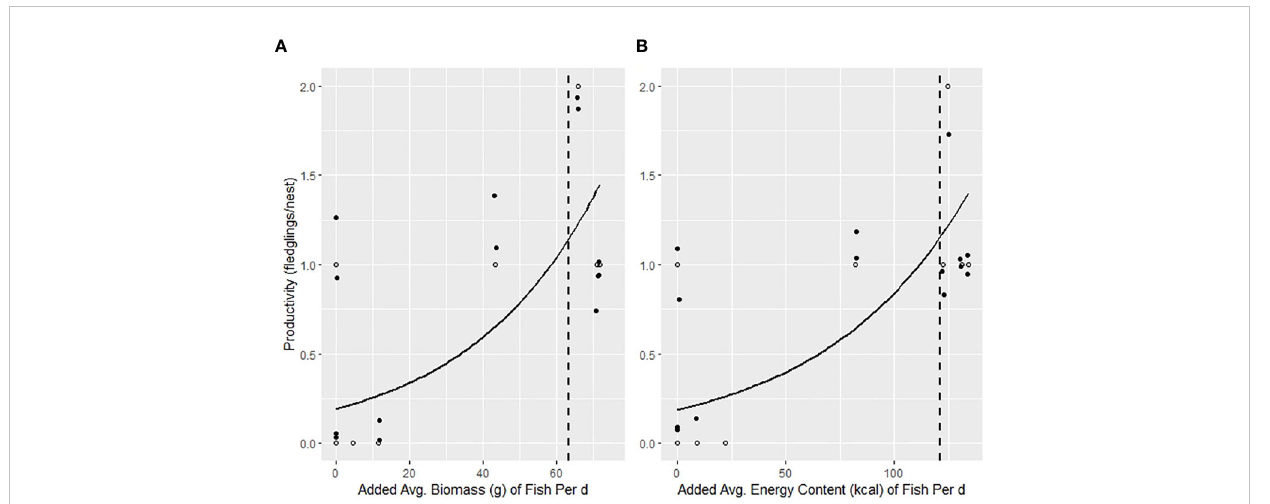
FIGURE 3 GLM ’ s of the in fl uence of the added (A) avg. biomass/d/nest ( b = 0.03, SE = 0.01, Pseudo R 2 = 0.60, CI = 0.01, 0.05, P = 0.02) and (B) avg. energy content/d/nest (kcal) ( b = 0.02, SE = 0.005, Pseudo R 2 = 0.64, CI = 0.006, 0.03, P = 0.02) for osprey pairs under trail camera surveillance after seven weeks post hatch of the fi rst egg in 2021 breeding season in the lower Chesapeake Bay, VA, USA. The data points represented by white circles have been “ jittered ” along with random points represented in black circles for improved visibility of model fi t. The dotted lines indicate the supplemented average biomass (63.4 g) and energy content (121 kcal) thresholds needed per d to produce 1.15 young per